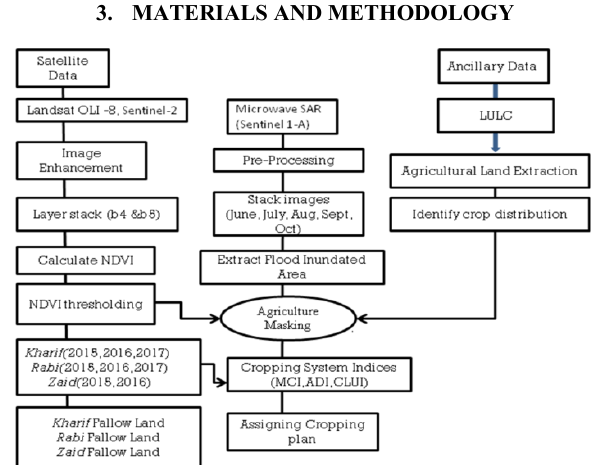
Figure 2. Methodology Flow chart